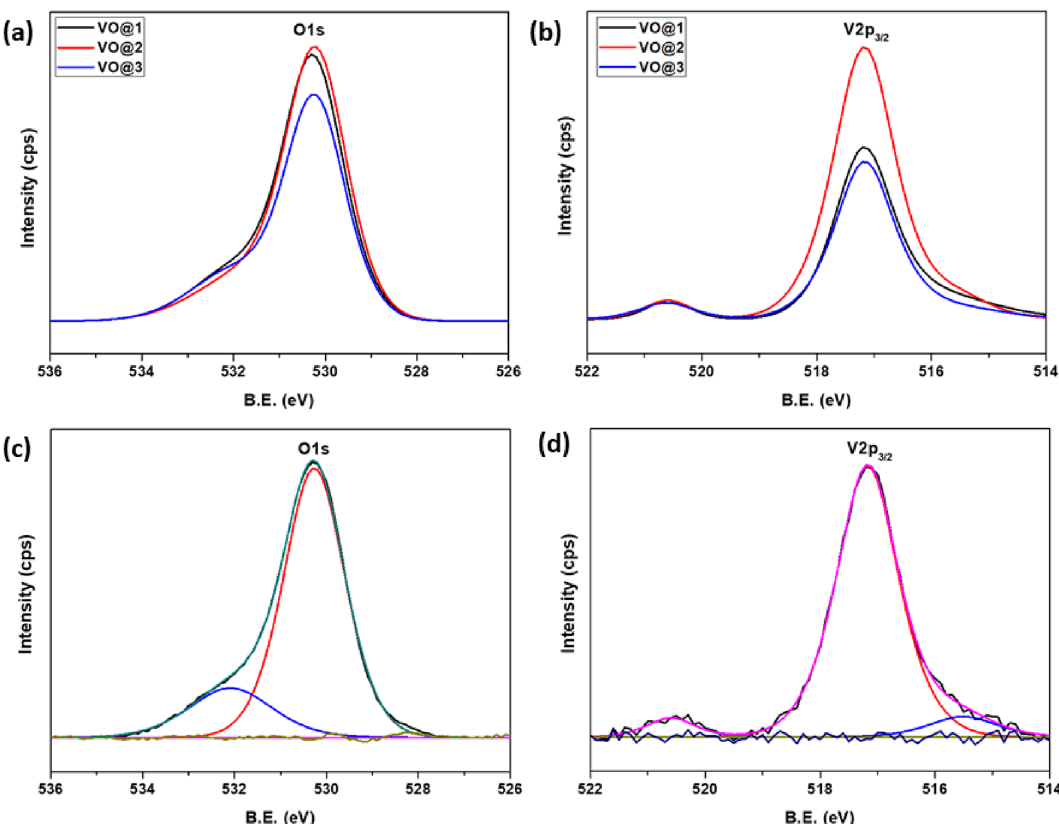
Figure 3. The normalized XPS spectra ( a ) O1s, ( b ) V2p 3/2 of all V 2 O 5 powders and ( c ) high-resolution spectra O1s, ( d ) V2p 3/2 of VO@2